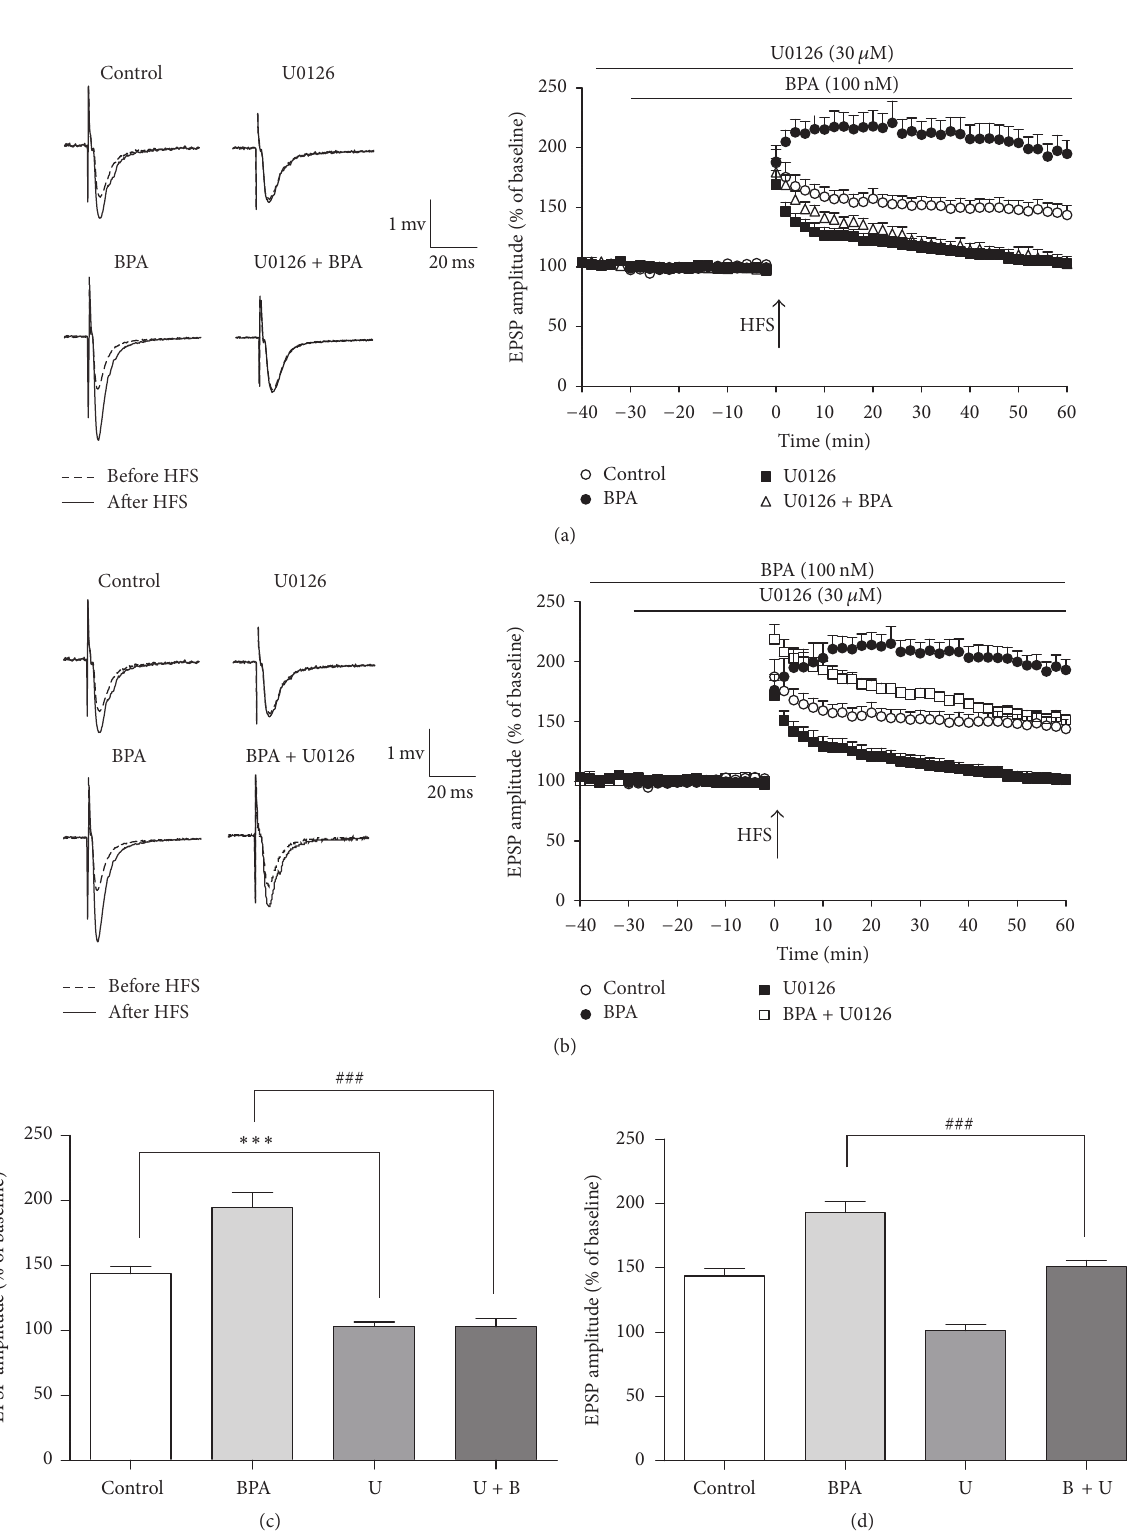
Figure 3: ERK signal pathway was involved in BPA-enhanced LTP. Pretreatment with ERK inhibitor U0126 for 30 min before BPA 100nM (open triangles, 𝑛 = 8 ) completely blocked LTP compared with controls. (b) Pretreatment with BPA 100 nM 30min before the ERK inhibitor (open squares, 𝑛 = 8 ) application remarkably decreased the BPA effect as compared with BPA 100 nM alone (open squares). (c, d) Figure columns showing the average fEPSP amplitudes at 60min after HFS in separate perfusion or coperfusion of BPA 100nM and U0 126 30 𝜇 M, ∗∗∗ 𝑝 < 0.001 as compared to the control, ### 𝑝 < 0.001 as compared to the BPA 100 nM. Solid and dashed example traces before HFS and after HFS,